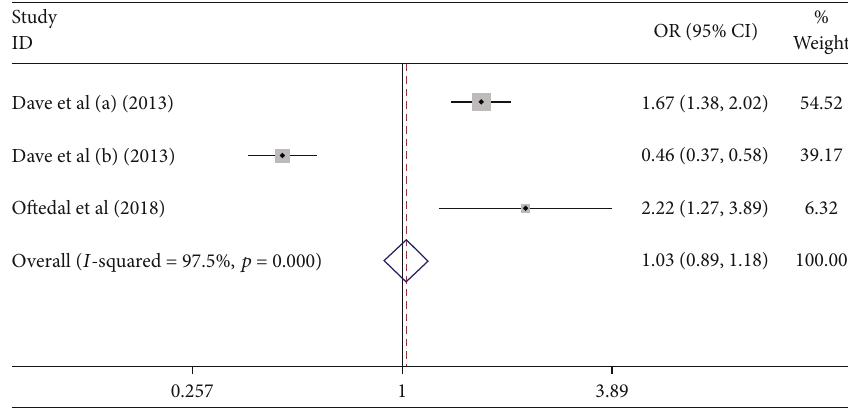
Figure 14: E ff ect size of age on the uncontrolled hypertension. Funnel plot with pseudo 95% confidence limits 0